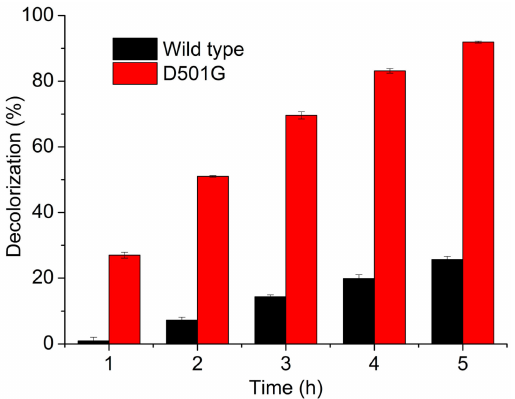
Figure 4. Decolorization of indigo carmine by the wild-type and D501G mutant at pH 9.0. Error bars represent the standard deviation of three